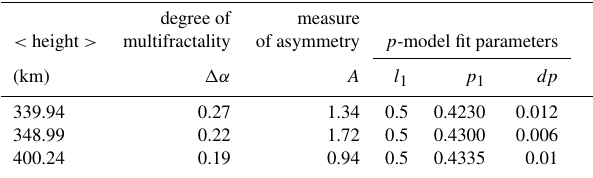
Table 2. Multifractal analysis measures for the second experiment: For the time series at mean heights listed in the first column, the sec- ond column shows degree of multifractality ( (cid:49)α ), the third column gives measure of asymmetry ( A ). Columns 4 to 6 lists the p -model fit parameters, l 1 , p 1 , dp